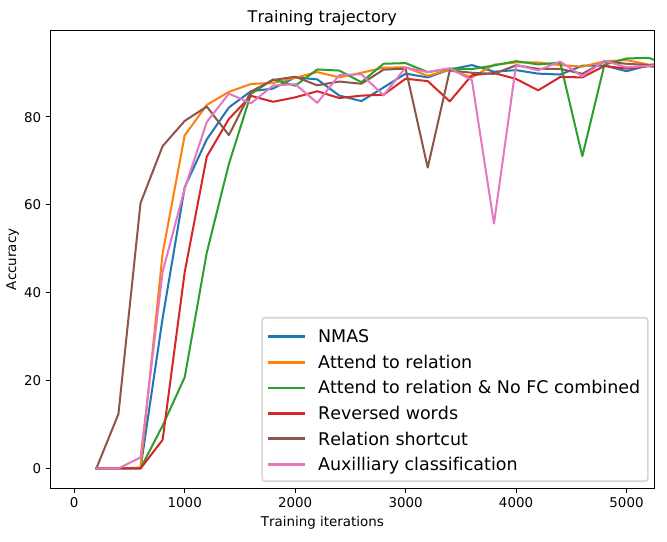
Prediction accuracy on the English validation set during training for some variations of the